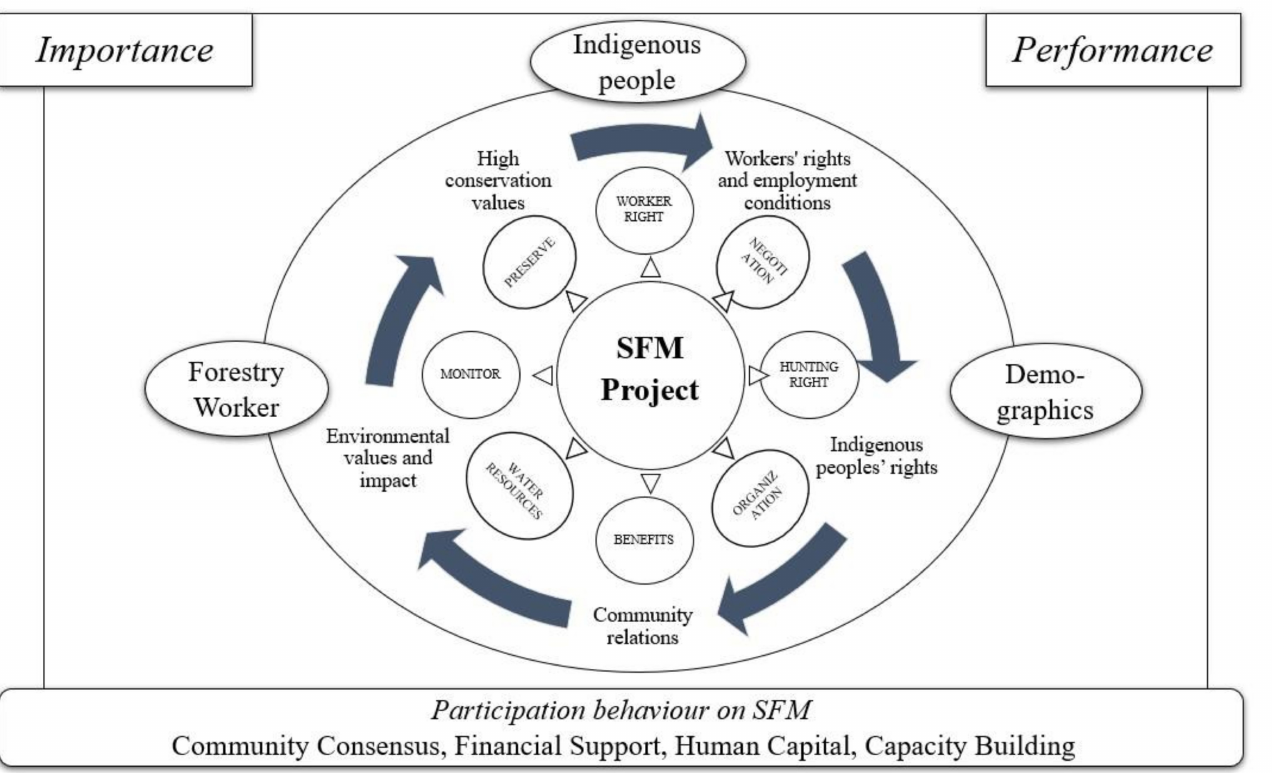
Figure 4. The evaluation framework of IPA for SFM in rural